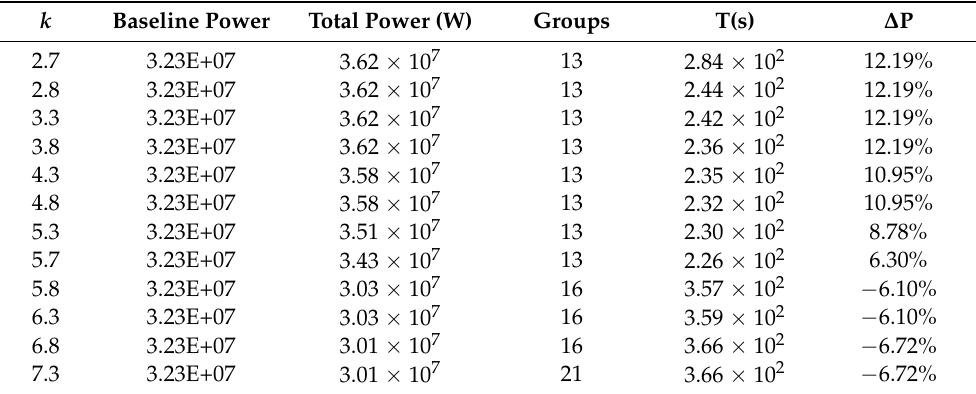
Table 2. Comparing the results of different pruning wakes under different k